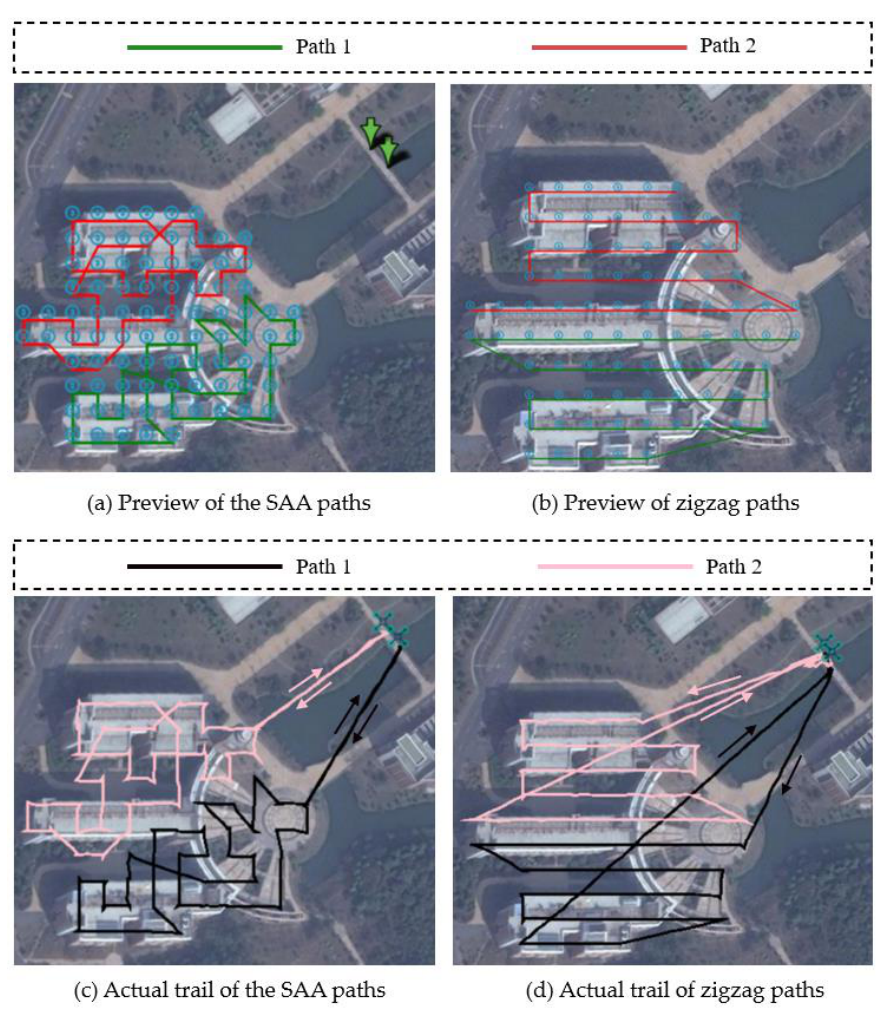
Figure 10. Previews and actual trails of the two paths. Table 2. Path lengths of the